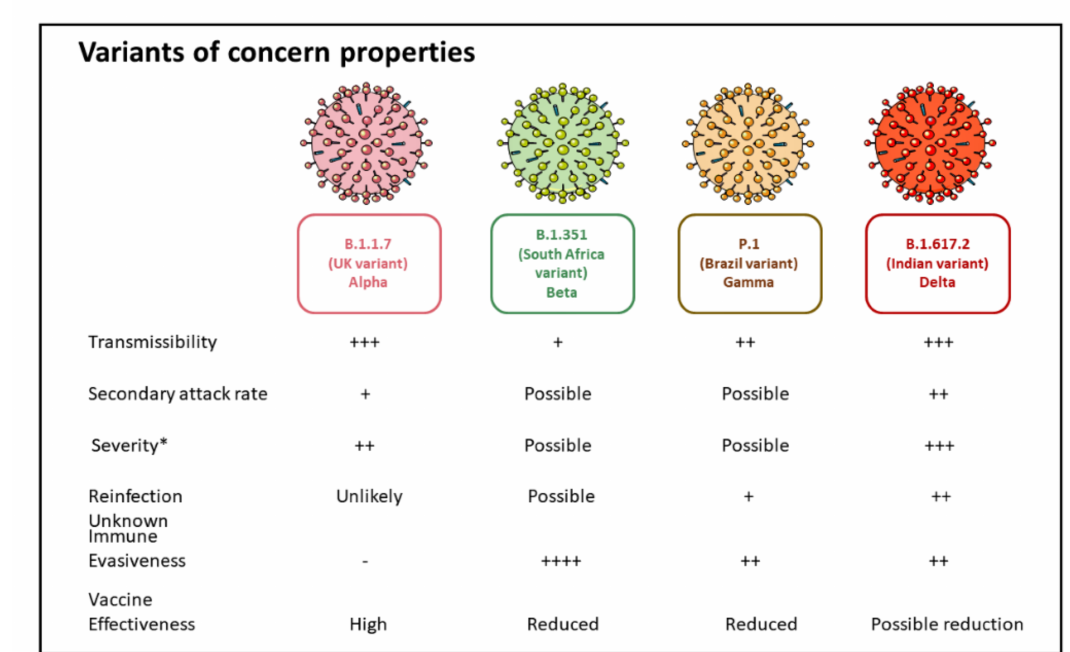
Figure 2. Properties of Current Variants of Concern. * Severity is determined by an increased risk of hospitalization and increased risk of